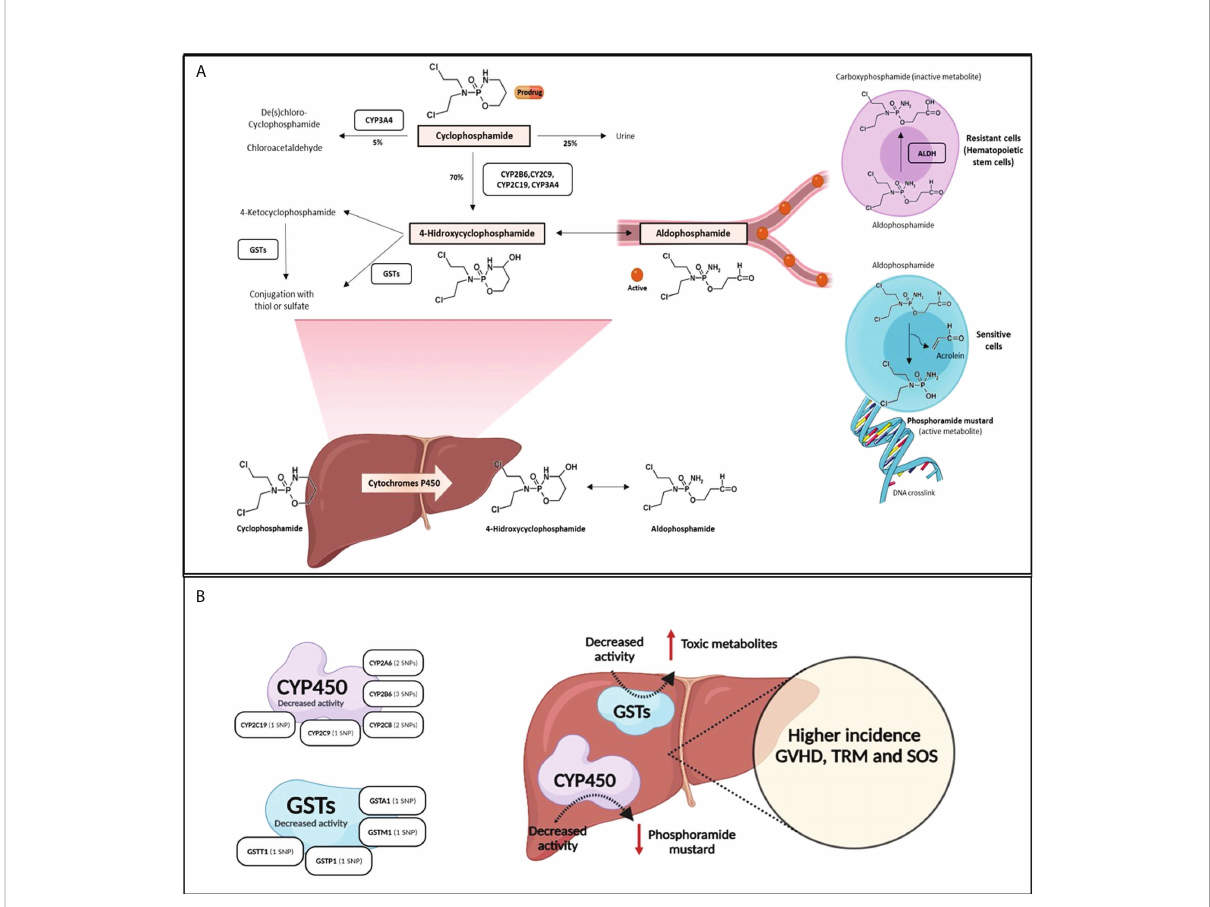
FIGURE 1 The metabolic pathway of cyclophosphamide. (A) . Cy (prodrug) is activated by the hepatic CYP450 to 4-hydroxycyclophosphamide, which stays in equilibrium with aldophosphamide. These two metabolites diffuse into cells. Depending on the type of cell, in cells with low concentration of ALDH (sensitive cells as lymohocytes), aldophosphamide is spontaneously converted to phosphoramide mustard and acrolein. However, in cells with high concentration of ALDH (resistant cells such as hematopoietic stem cells) aldophosphamide is converted to carboxyphosphamide (inactive). (B) shows SNPs effect in Cy metabolism enzymes: SNPs in CYP450 and GSTs enzymes lead to decreased activity enzyme and produce low level of phosphoramide mustard and high level of toxic metabolites, respectively. This SNPs lead to higher incidence of GVHD, SOS and